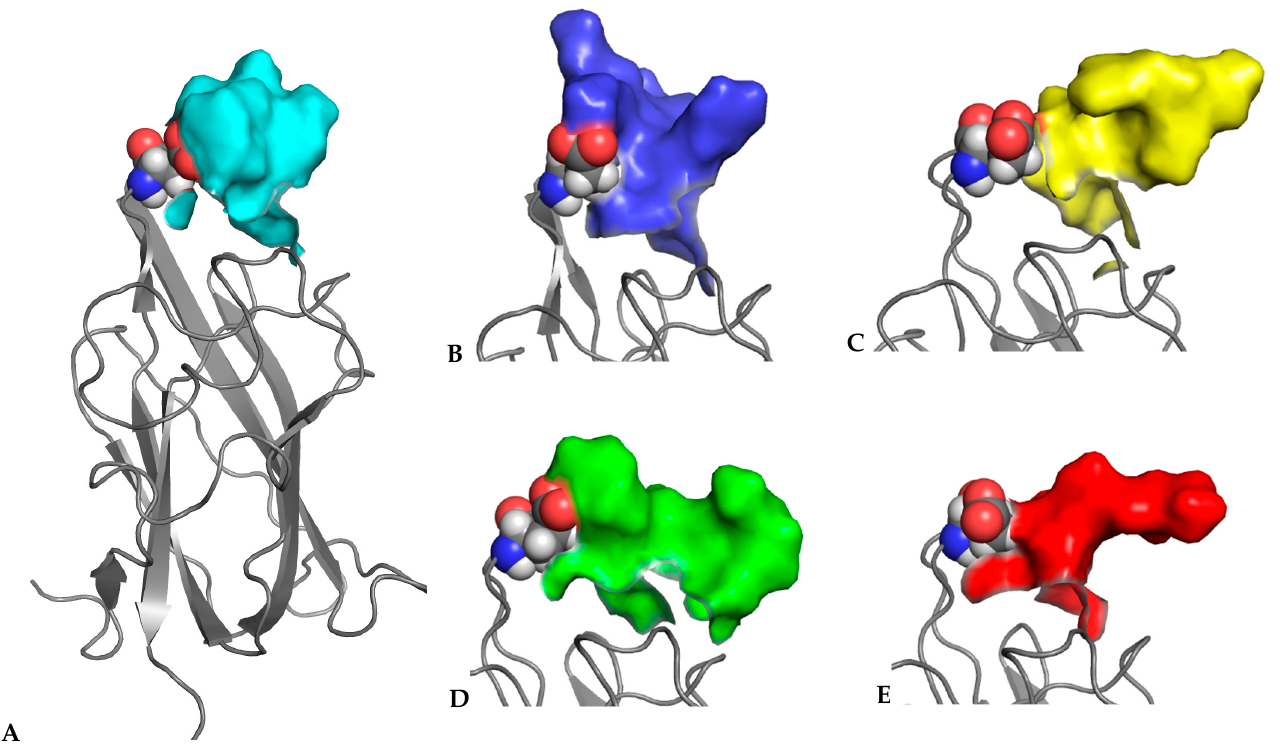
Figure 3. Representative structures of NRP1 in complex with peptides ( A ) C(cyan), ( B ) B167 (blue), ( C ) B186 (yellow), ( D ) A165 (green) and ( E ) control (red). Centroids of the most populated clusters for each of the complexes were extracted from trajectories of 30 ns molecular dynamics simulations, with NRP1 shown as a grey ribbon and Glu348 in CPK representation, while the peptides were shown as solvent-accessible surfaces. Differences in the molecular surfaces for each of the peptides will result from the combination of different backbone conformations and the size of the side chains within the sequences of the specific peptides.